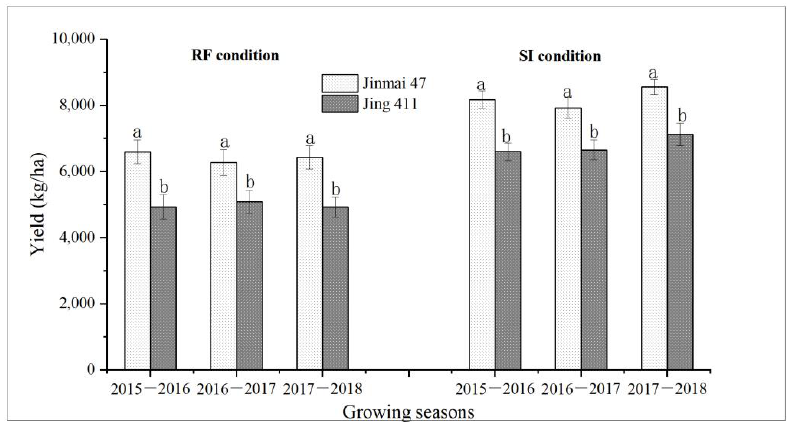
Figure 3. Total evapotranspiration (TET) over the whole growing season for the genotypes Jinmai 47 and Jing 411 under rain-fed (RF) and supplemental irrigation (SI) conditions. For each growing season, different letters indicate significant differences between the two genotypes at p < 0.05 based on the LSD test. Vertical bars indicate the standard deviation. With the SI, PT and E, the sum ET increased more in Jing 411 than in Jinmai 47 (Figure